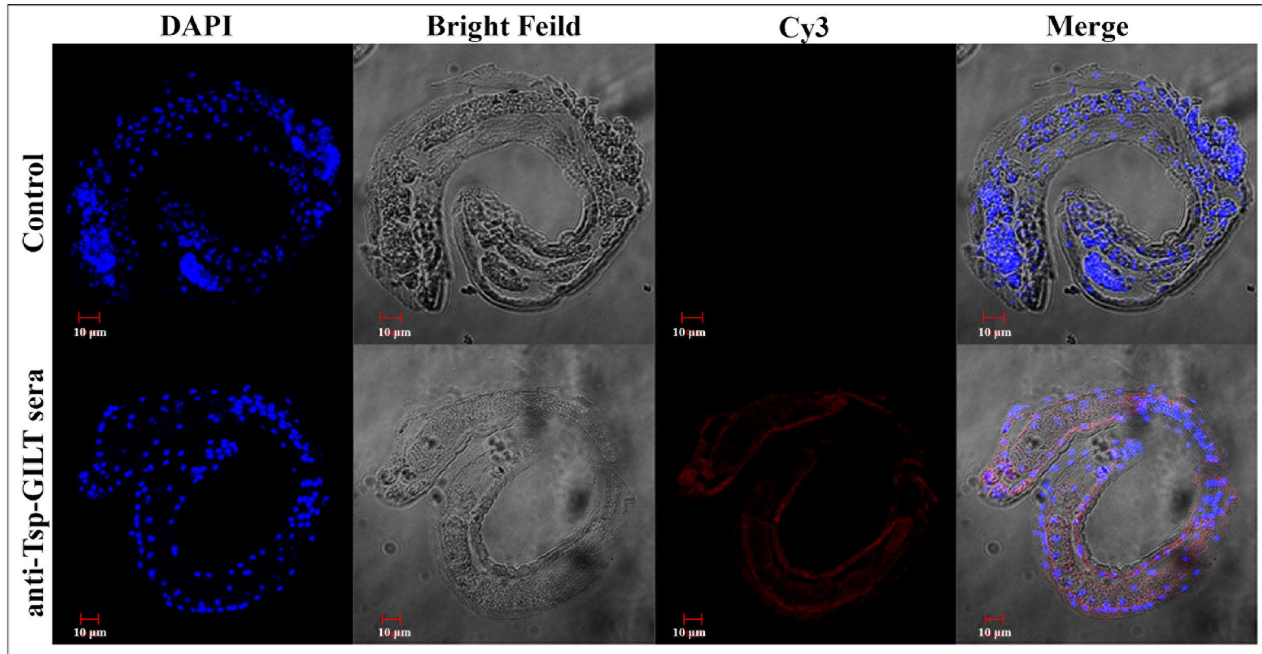
Fig 3. Localization of Tsp-GILT in T . spiralis ML by immunofluorescence assay. First line is negative control group, second line is experience group. Nuclei were stained with DAPI (blue) and target protein with Cy3 (red). No red fluorescence was observed in control.